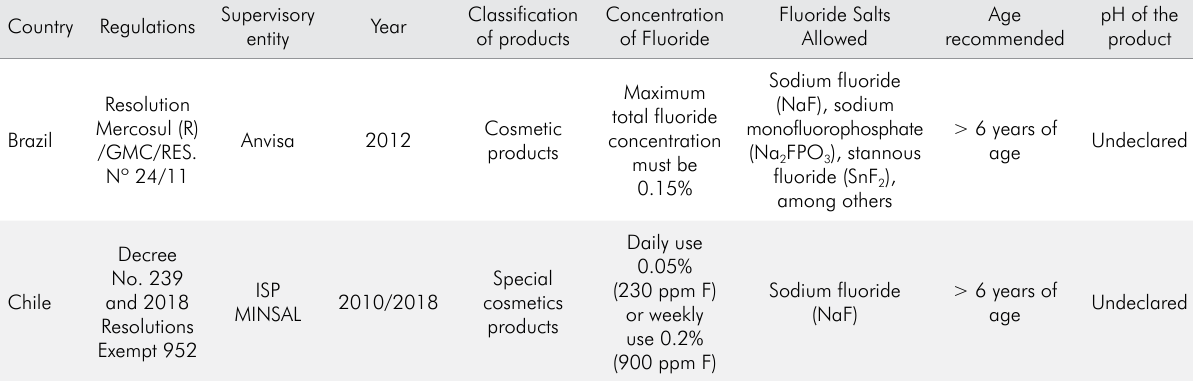
Table 2. Specifications regarding the Brazilian and Chilean fluoride mouthwash regulations.